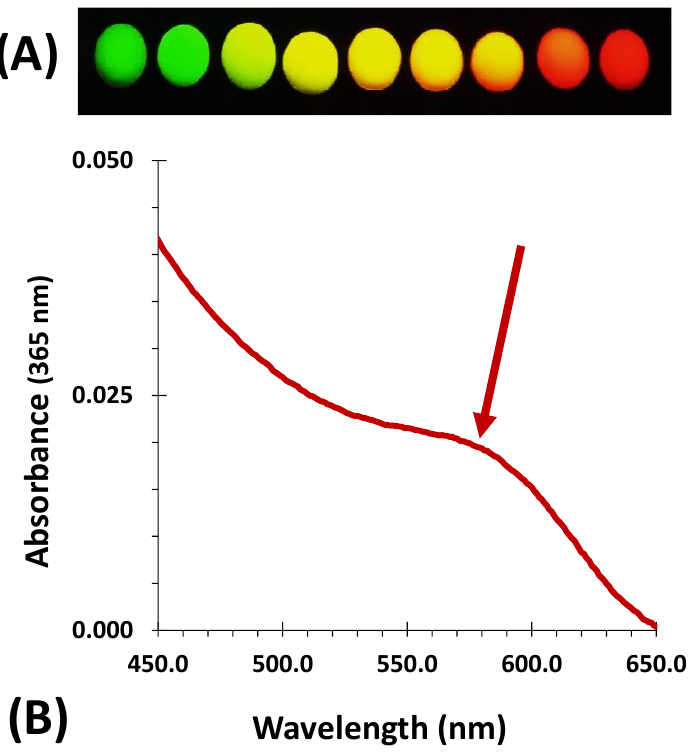
Figure 2. ( A ) Crude solutions of the CdTe@MPA QDs taken along their synthesis and photographed under a 365 nm UV lamp. ( B ) UV–Vis spectrum of the red-emitting QDs with the maximum wavelength at 580 nm was selected as the maximum absorption wavelength of the red-emitting QDs.